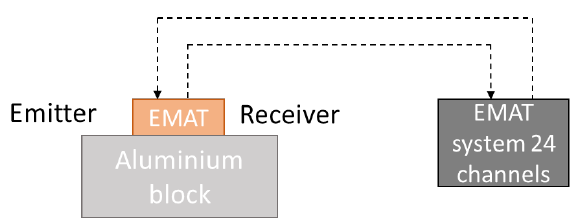
Figure 13. Experimental setup for pulse echo measurement—emission and reception by the EMAT.